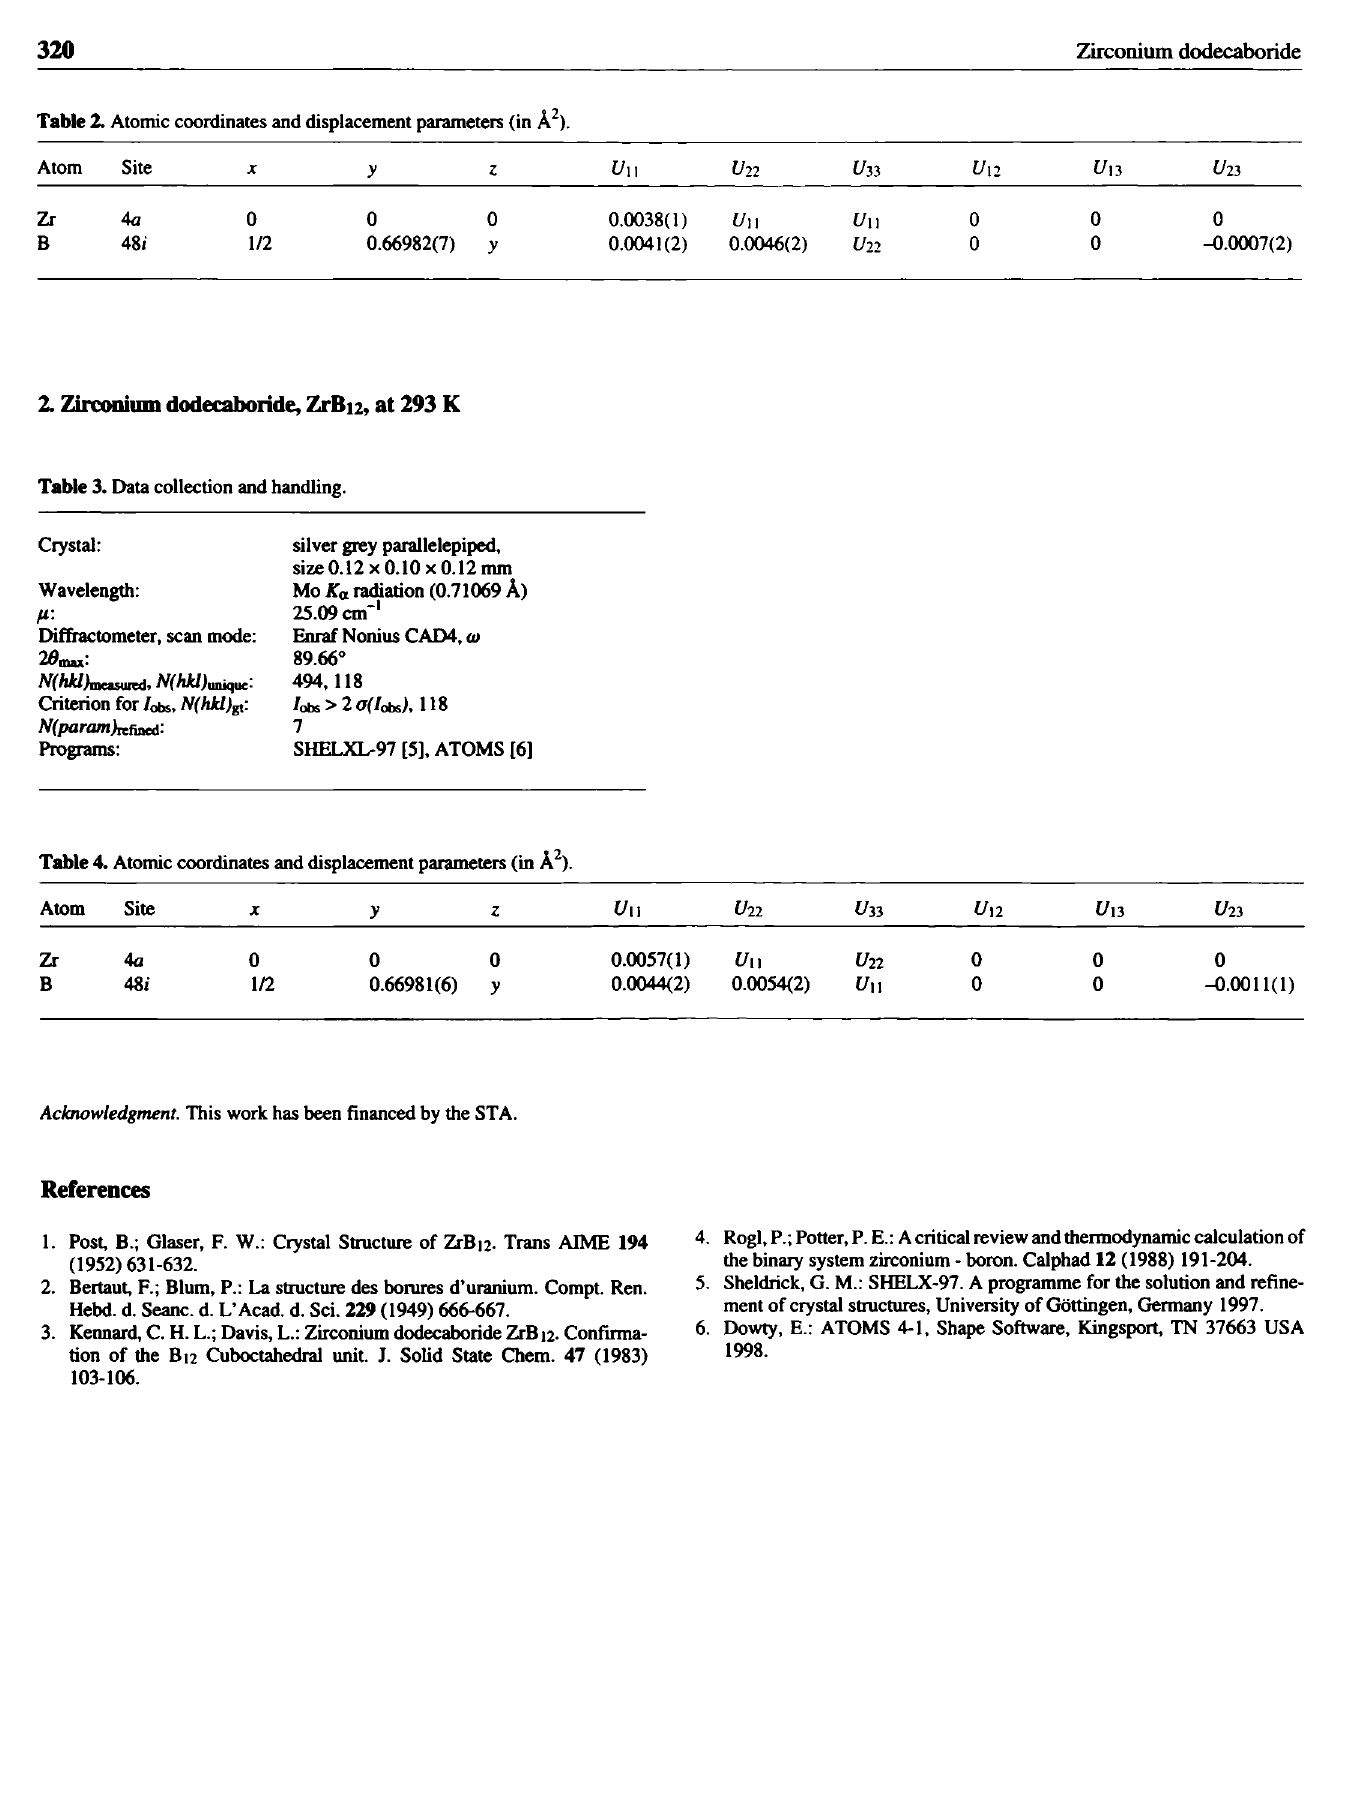
Table 3. Data collection and handling.